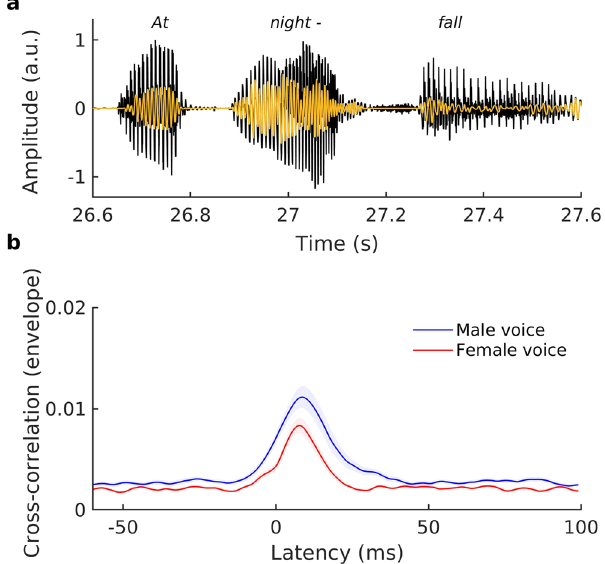
Figure 1. Auditory brainstem response to running speech. ( a ) Speech (black) consists of many voiced parts that are characterized by a fundamental frequency that varies over time. We compute a fundamental waveform (yellow) that, at each time point, oscillates at the fundamental frequency. ( b ) We compute the cross-correlation of the brainstem response with the fundamental waveform to measure the brainstem response to speech when subjects are presented with two competing speakers, a male and a female voice. The envelope of the cross- correlation of the neural recording with the fundamental waveform of the male speaker (blue line: population mean, blue shading: population standard error of the mean) peaks at 8.3 ms. The female voice causes a similar brainstem response, although at a smaller magnitude (red line: population mean, red shading: population standard error of the